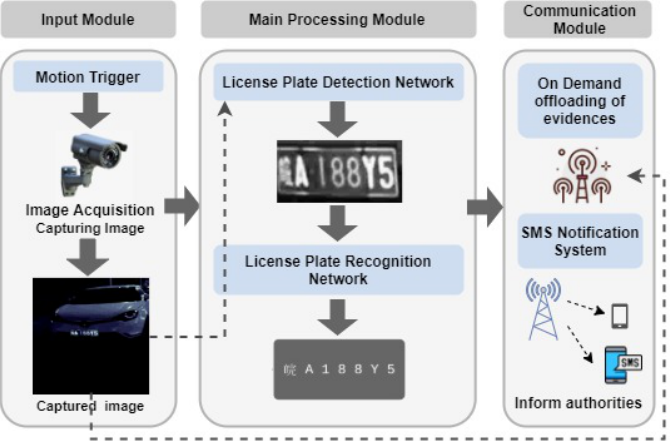
Figure 1. Overview of the proposed model.